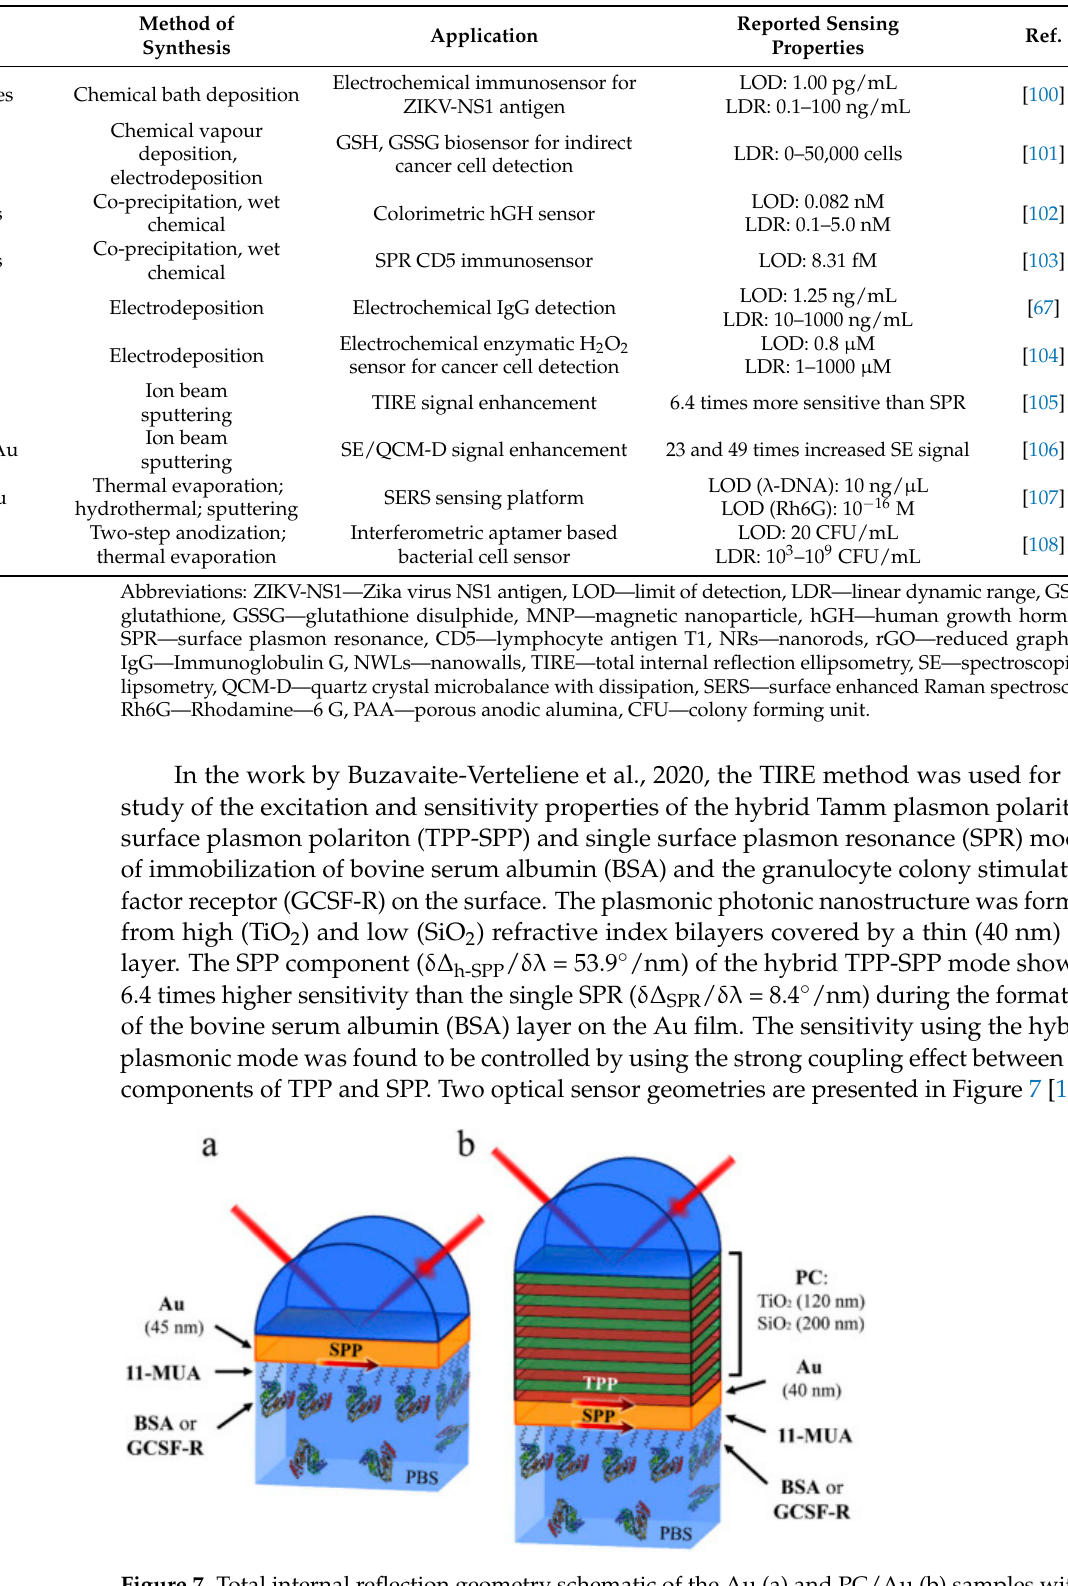
Figure 7. Total internal reflection geometry schematic of the Au (a) and PC/Au (b) samples with a self-assembled monolayer of 11-mercaptoundecanoic acid (11-MUA) and the GCSF-R or BSA